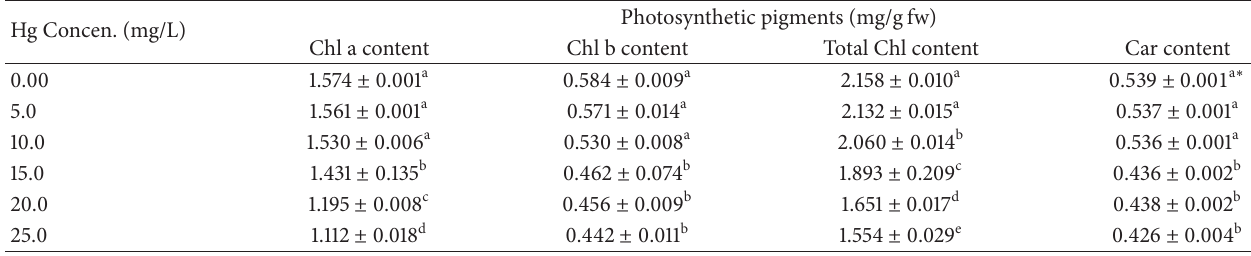
Table 2: Effects of mercury heavy metal induced stress on chlorophyll a, b and carotenoid contents in leaves of M. arvensis seedlings along with untreated control.